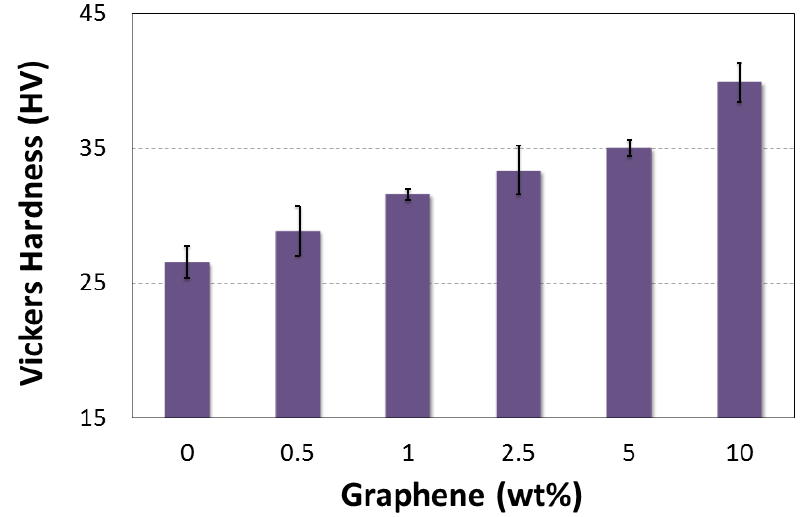
Figure 16. Effect of graphene additives on NGP/epoxy hardness.